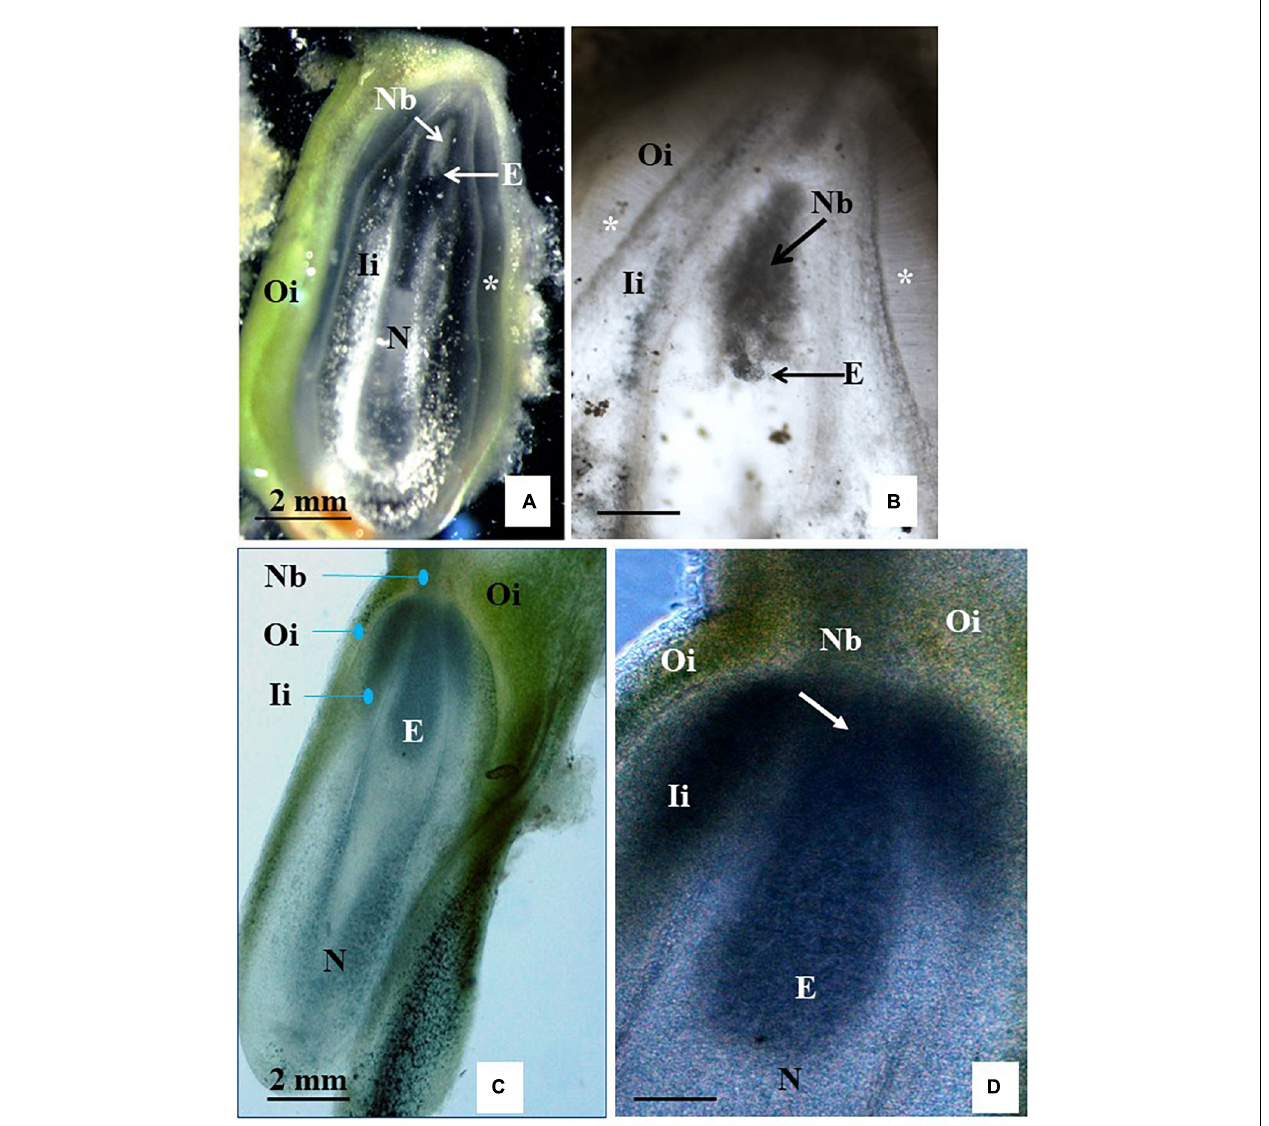
FIGURE 6 | Free-hand longitudinal sections of unpollinated ovules from carpel cultures using Method C and two-step induction system. Sections of ovules cultured on solid BDS medium (A , B) or on solid F6 medium (C , D) for 6 weeks and then transferred to R medium. (B) Shows an enlargement of the micropylar side of the section (A) to expose the structure better, which resembles a globular embryo (E, pointed to by arrow). The outer integument (Oi) shows chlorophyll, while its fragment lying on the medium started callusing. The inner integument (Ii) is mostly degenerated without traces of callus formation. Cell wall fragments glitter in the dark field illumination. As during natural process of testa formation, cells of inner epidermis of Oi elongated perpendicularly to the surface, forming a distinguished layer (marked with small stars). Nucellus (N) and especially nucellar beak (Nb) accumulated starch grains. Embryo sac is visible as an empty cavity (black in A and translucent white in B ). (C) Shows a slight spot of callus on the Oi. The Oi remained green similar to (A) . (C,D) Show a torpedo-stage embryo that is closely attached to Nb. (D) An arrow points to the site of the embryo attached to the starch-reach beak region at the micropylar side end of the embryo sac. Sections were obtained using freshly collected material and show their natural color. (A) Images in dark field illumination using an inverted Nikon ECLIPSE Ti-S microscope. (B–D) Images in light illumination using a Nikon Eclipse 55i microscope. Photographs were taken by placing the sections in drops of water covered with a cover